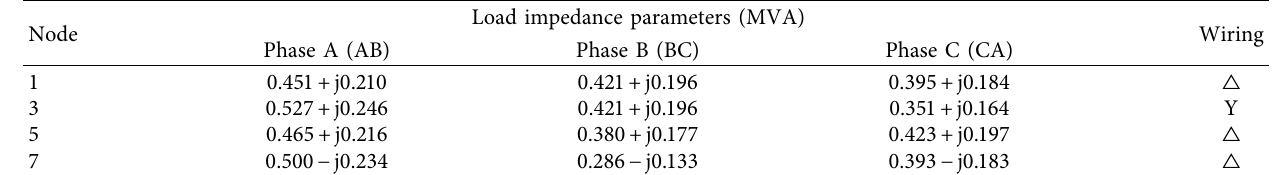
Table 1: Nodal load impedance